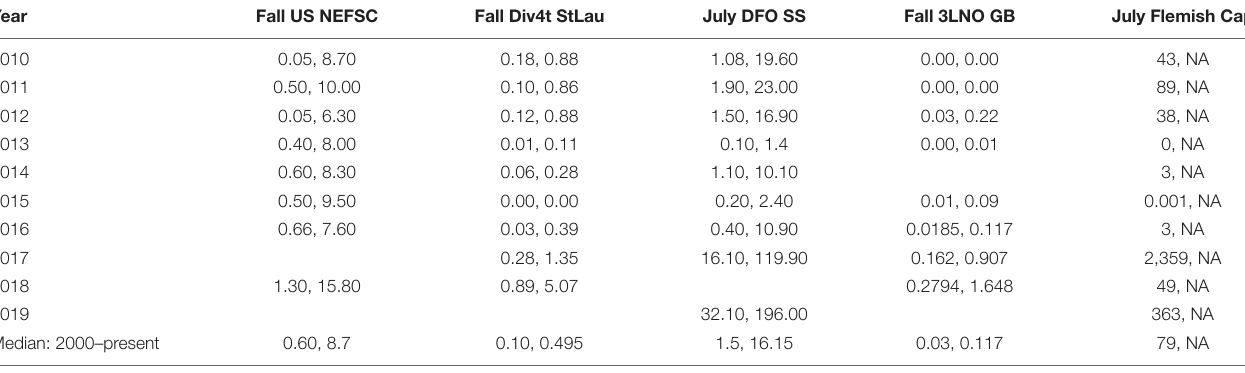
TABLE 2 | Indices ofshortfin squid abundance (mean kilogram per tow, mean number per tow) from fishery-independent bottom trawls surveys: Fall North East Fisheries Science Center (US NEFSC), Fall southern Gulf of St. Lawrence (Div4t StLau), July Scotian Shelf and Bay of Fundy (DFO SS), Fall Grand Banks (3LNO GB), and July Flemish Cap.